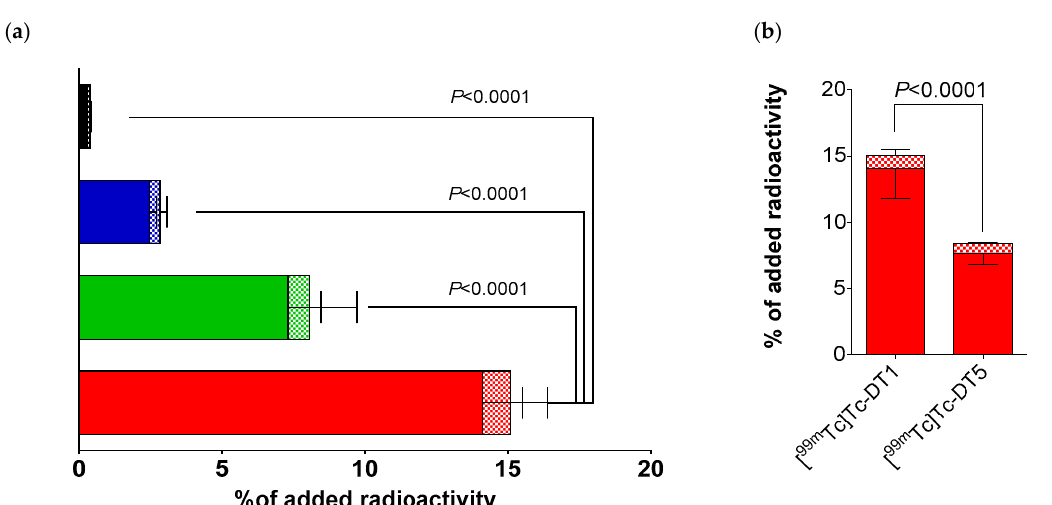
Figure 2. ( a ) Neurotensin subtype 1 receptor (NTS1R)-specific cell uptake of [ 99m Tc]Tc–DT1 in AsPC-1 (red column), PANC-1 (green column), MiaCapa-2 (blue column), and Capan-1 (black column) cells during 1 h incubation at 37 °C. ( b ) Comparison of NTS1R-specific uptake of [ 99m Tc]Tc–DT1 and [ 99m Tc]Tc–DT5 in AsPC-1 cells during 1 h incubation at 37 °C; solid bars: internalized fraction; checkered bars: membrane-bound fraction. Results represent average values ± SD ( n = 3, in triplicate); non-specific values were obtained in the presence of 1 μ M neurotensin (NT), and were subtracted from totals to provide specific values. The study was conducted with cells as confluent monolayers.